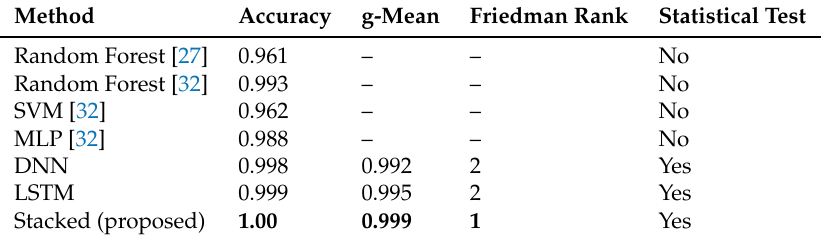
Table 14. Performance evaluation of the NetML-2020 test set; best results are indicated with bold.